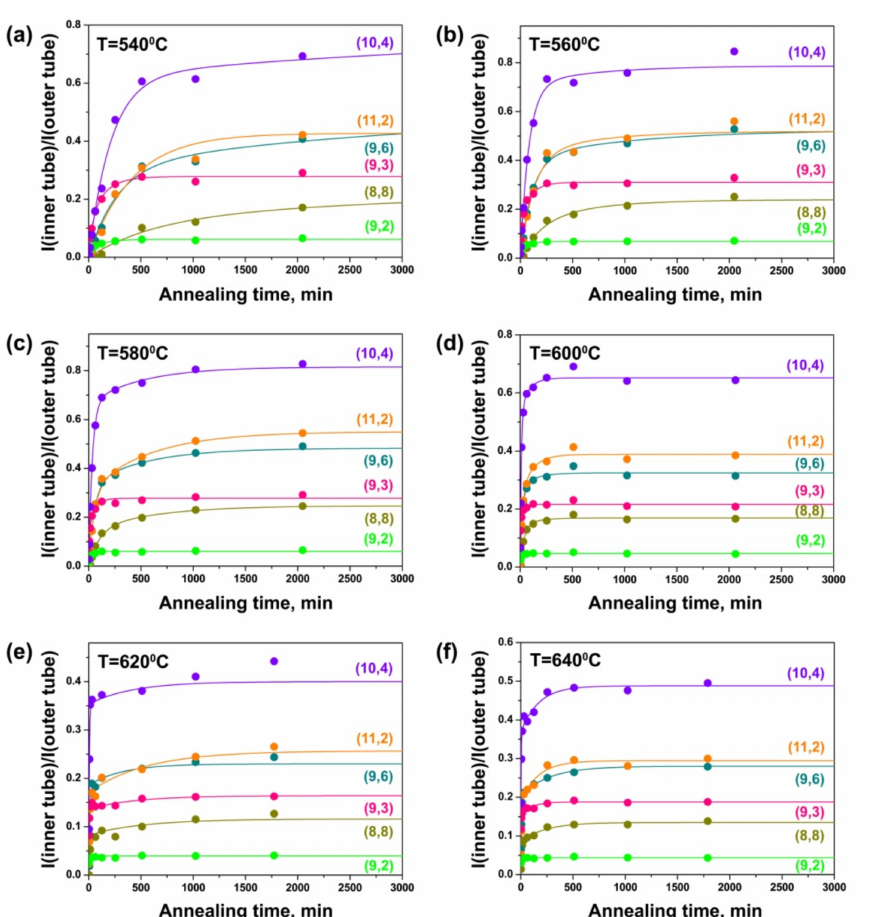
Figure 10. The integral intensity of peaks of the (8,8), (9,6), (10,4), (11,2), (9,3) and (9,2) inner tubes normalized to the intensity of the outer tube peak observed in the RBM-band of Raman spectra of the annealed CoCp 2 -filled SWCNTs acquired at a laser wavelength of 568 nm (E ex = 2.18 eV) plotted versus annealing time. The experimental data for the samples annealed at temperatures of 540 ◦ C ( a ), 560 ◦ C ( b ), 580 ◦ C ( c ), 600 ◦ C ( d ), 620 ◦ C ( e ) and 640 ◦ C ( f ) are shown as filled circles. The fitting results of the data are presented as solid